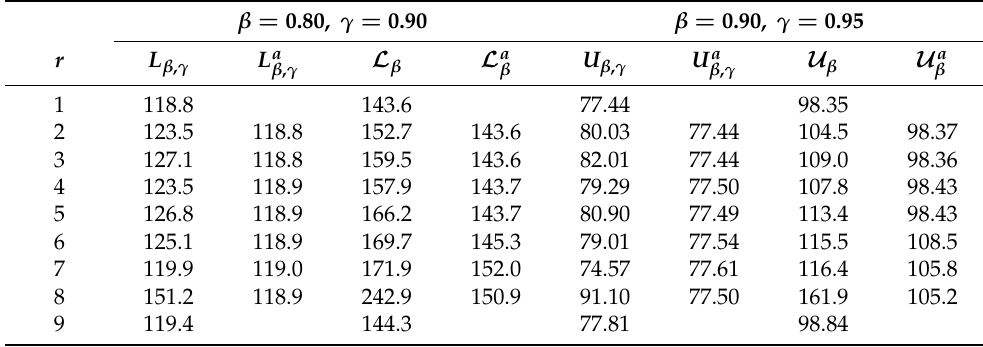
Table 7. Unconditional and conditional lower and upper ( β , γ ) -TLs and β -ETLs when r = 1, . . . ,9 in Example 2.